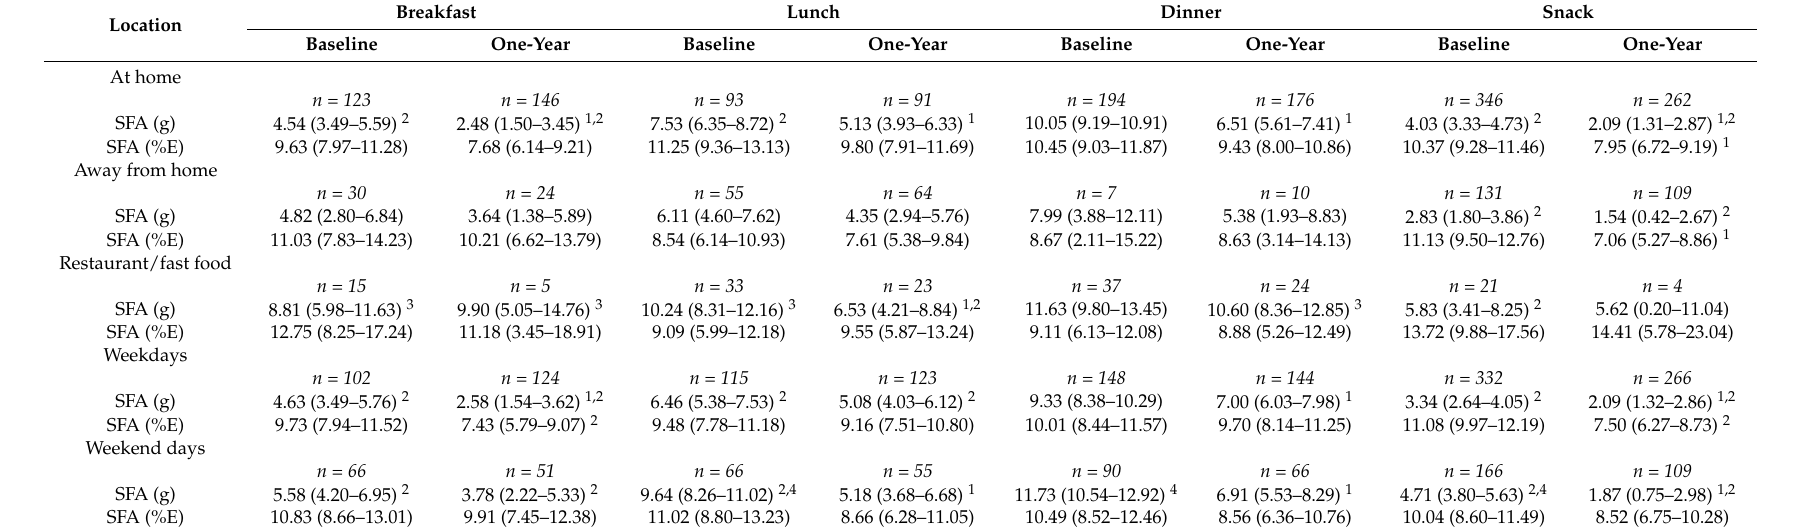
Table 4. SFA intake by meal type, weekday and location at baseline and one